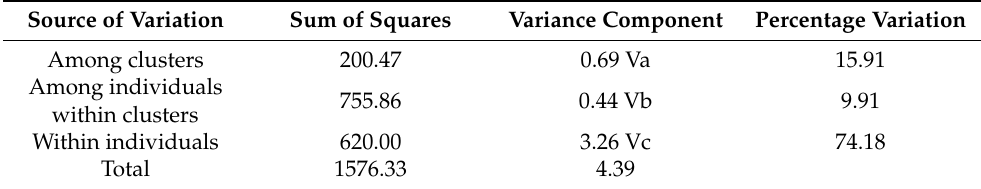
Table 5. Analysis of molecular variance (AMOVA) was conducted by grouping trees into their respective genetic clusters. Source of Variation